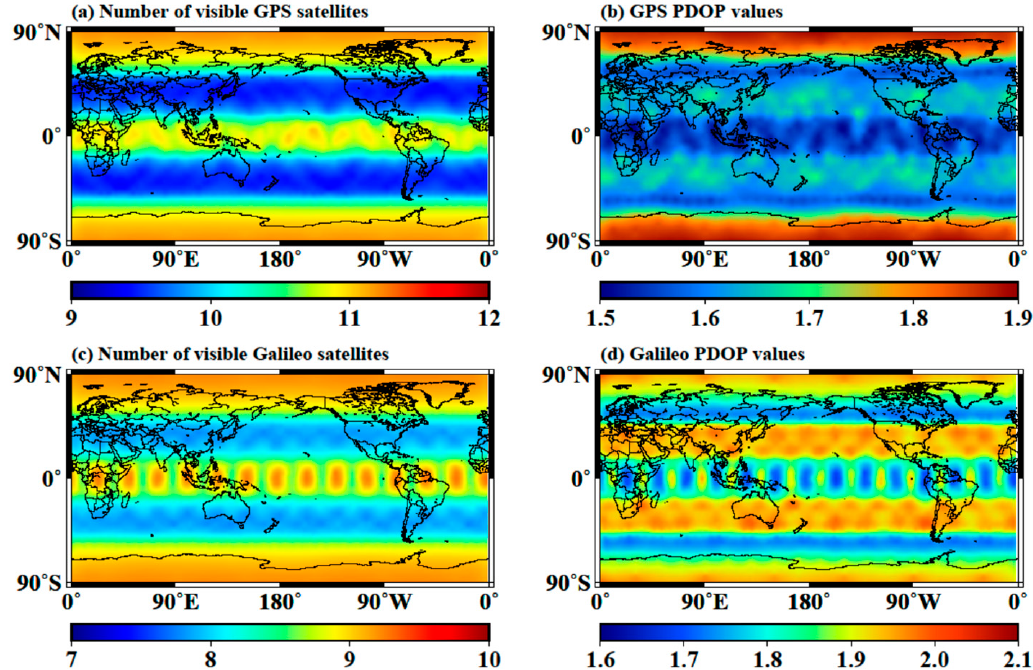
Figure 2. Distribution of number of visible satellites and position dilution of precision (PDOP) value for GPS and Galileo constellation on days of year (DOYs) 190 to 196 in 2020. ( a ) Number of visible GPS satellites; ( b ) GPS PDOP values; ( c ) number of visible Galileo satellites; and ( d ) Galileo PDOP values.